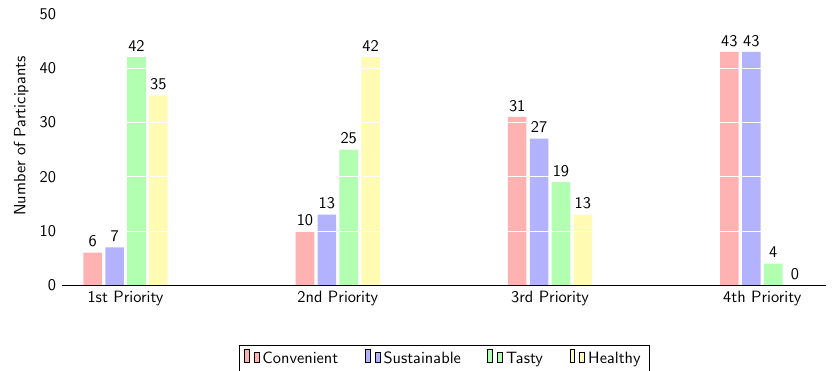
Figure 3. Arranged importance of four characteristics of meals for the respondent’s child, 1 = most important, 4 = less